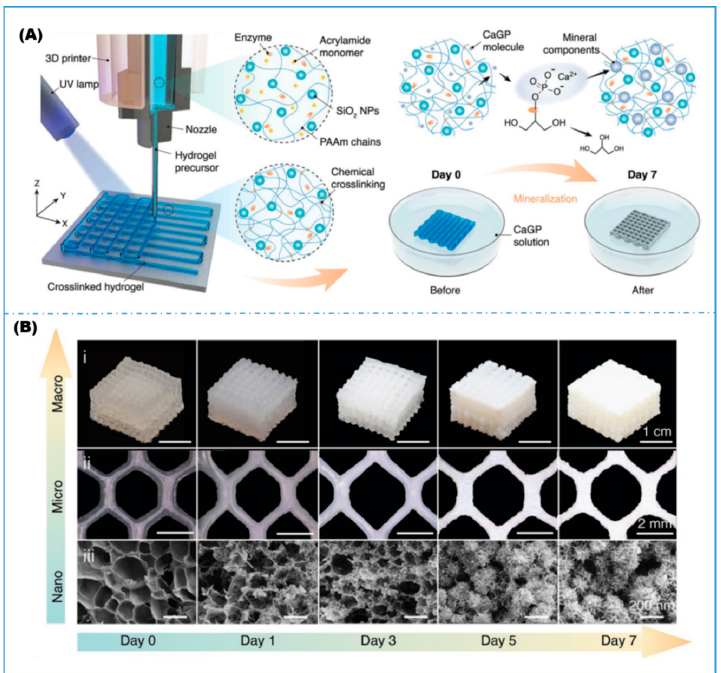
Figure 8. Biomineralized 3D printed hydrogel. ( A ) Schematic protocols for printing enzyme-loaded hydrogel precursors and enzyme-induced biomineralization. ( B ) Multi-scale observations of the mineral growth in hydrogel (reproduced with permission from Ref. [74]).